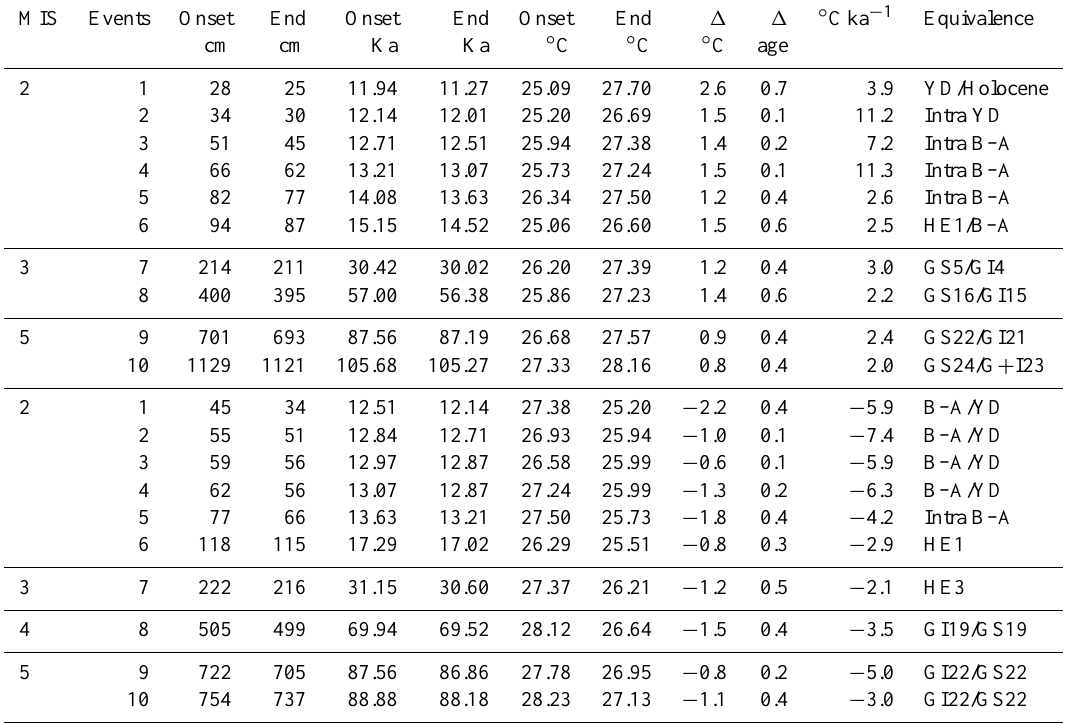
Table 3. List of the abrupt SST changes identified in the MD03-2616 core. They are defined as positive or negative increments represented by ≥ 3 samples, occurring faster than the average SST warming during the last deglaciation, + 2 ◦ Cka − 1 (3.1 ◦ C in 1550 years in this SST record), and higher than ± 0.5 ◦